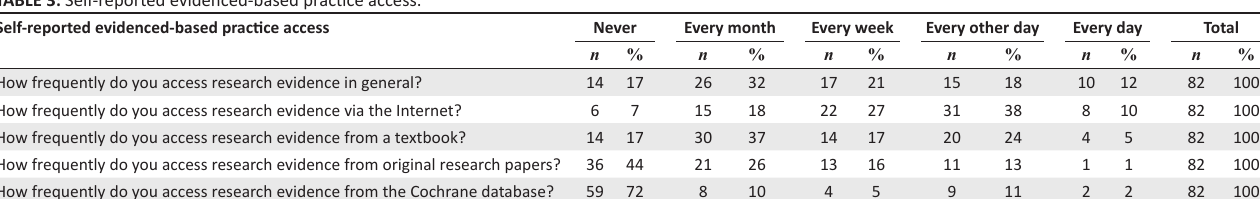
TABLE 3: Self-reported evidenced-based practice access.